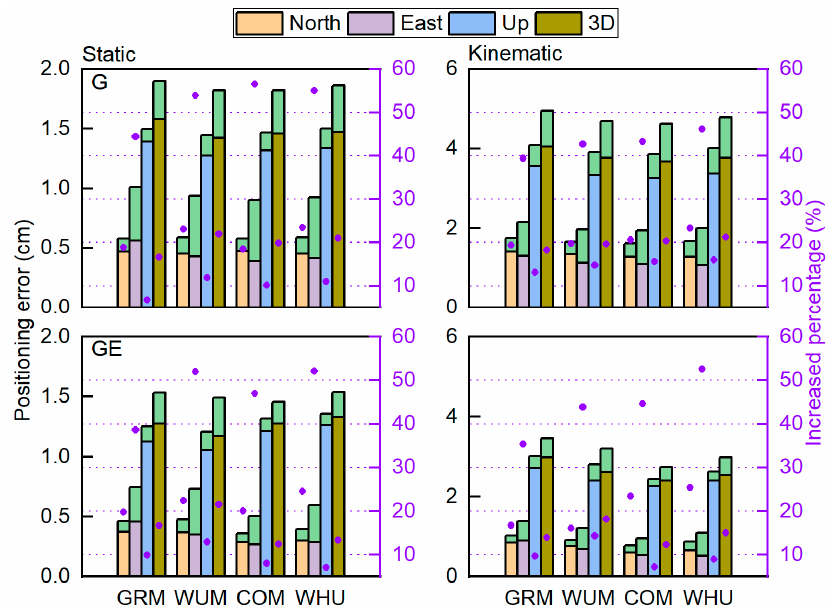
Figure 4. Averaged positioning error of GPS-only and GE float/fixed PPP static (left) and kinematic (right) in north, east, up, and 3D components with GRM, WUM, COM, and WHU products. The orange, purple, blue, and brown pillar denotes fixed PPP solution in north, east, up, and 3D components, which plus green pillar represents the corresponding float PPP solution. The blue dots show the increased percentage of the fixed solution compared to the float. Table 2. The means RMS (cm) of GPS-only and GE float/fixed PPP static/kinematic positioning errors with four ACs products, where N means the north component, the E means east component, and U means the up component. Static Kinematic Float Fix Float